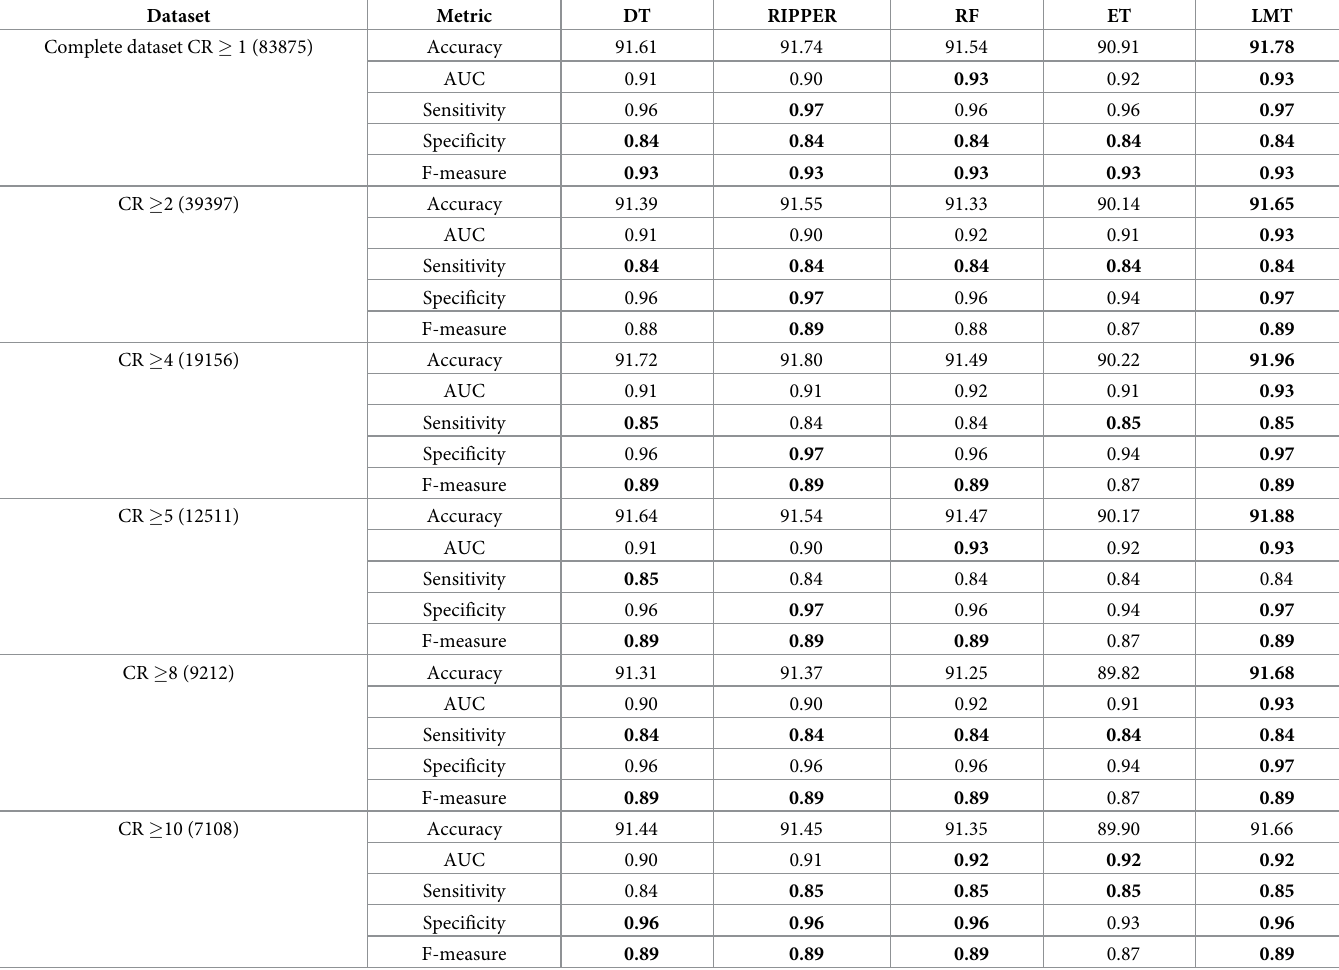
Table 9. Results of the six datasets (full attributes) based on different accident